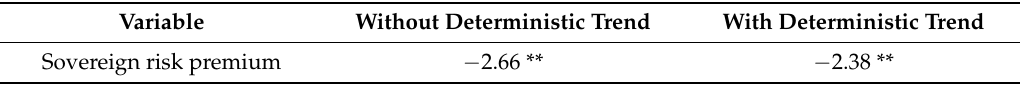
Table 3. Pedroni residual-based cointegration